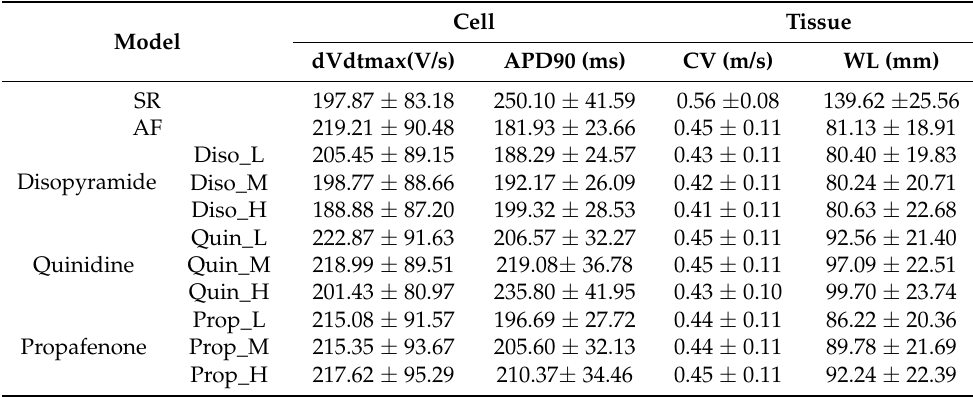
Figure 5. Effects of low (L), medium (M), and high (H) doses of disopyramide (Diso), quinidine (Quin), and propafenone (Prop) on the atrial fibrillation (AF) population. Using the Bai et al. model, simulated changes in APD90 ( a ) and dVdtmax ( b ) following the application of drugs at different doses in comparison to the drug-free conditions in the AF population or in the normal population for sinus rhythm (SR). Using the Grandi et al. model, ranges of APD90 ( c ) and dVdtmax ( d ) in conditions of drug-free SR, drug-free AF, AF in the presence of disopyramide at low (Diso_L), medium (Diso_M), and high (Diso_H) doses, AF in the presence of quinidine at low (Quin_L), medium (Quin_M), and high (Quin_H) doses, and AF in the presence of propafenone at low (Prop_L), medium (Prop_M), and high (Prop_H) doses. Each boxplot represents the range covered by the ionic conductances: The edges of the box are the 1st and 3rd quartiles, the whiskers extend to the most extreme datapoints, the estimated median physiological value is the central horizontal line and the notch around the median is the 5% significance level (Mann–Whitney U test: * p < 0.05; ** p < 0.01; *** p < 0.001). Table 6. A quantitative summary of the effects of class I antiarrhythmic drugs on human atrial electrical activity using the Bai et al.